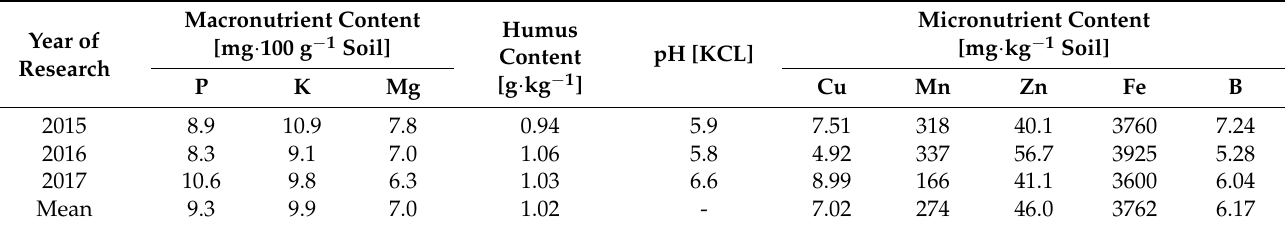
Table 3. Soil characteristics before establishing the